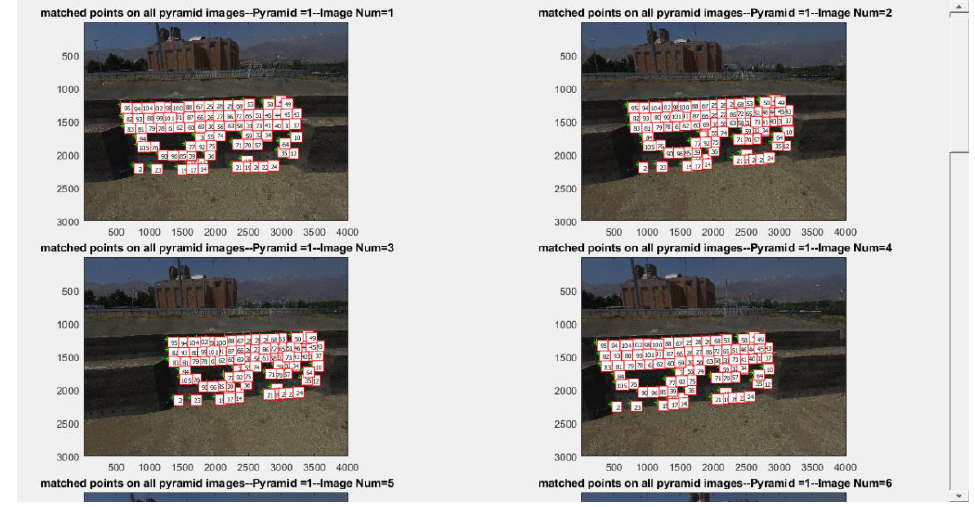
Figure 8. Final corresponding points extracted from images.